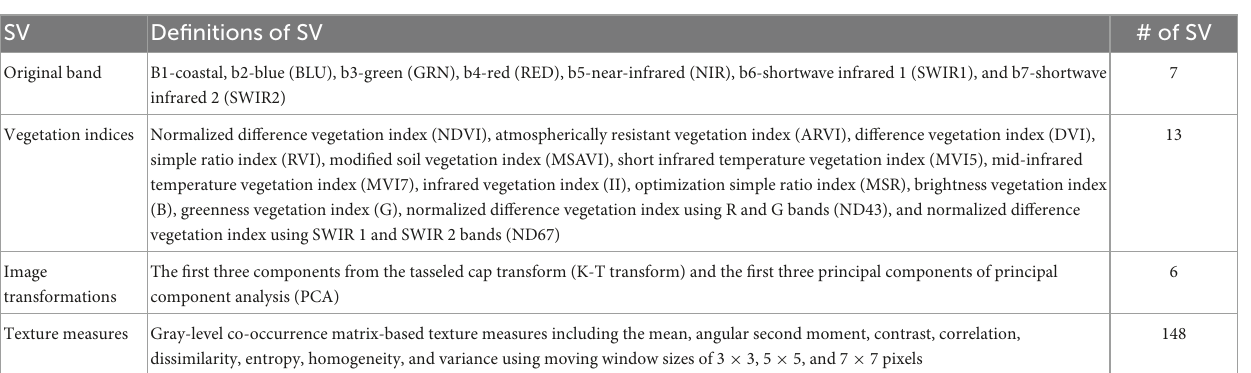
TABLE 2 Spectral variables derived from a total of seven bands for the Landsat 8 OLI image.